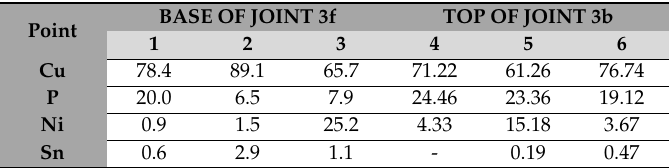
Table 1. EDS composition (at. %) at di ff erent points marked in Figure 3b,f for the top and base of the joint brazed at 660 ◦ C for 15 min.